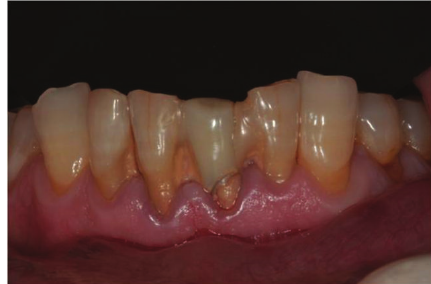
Figure 2: Preoperative clinical